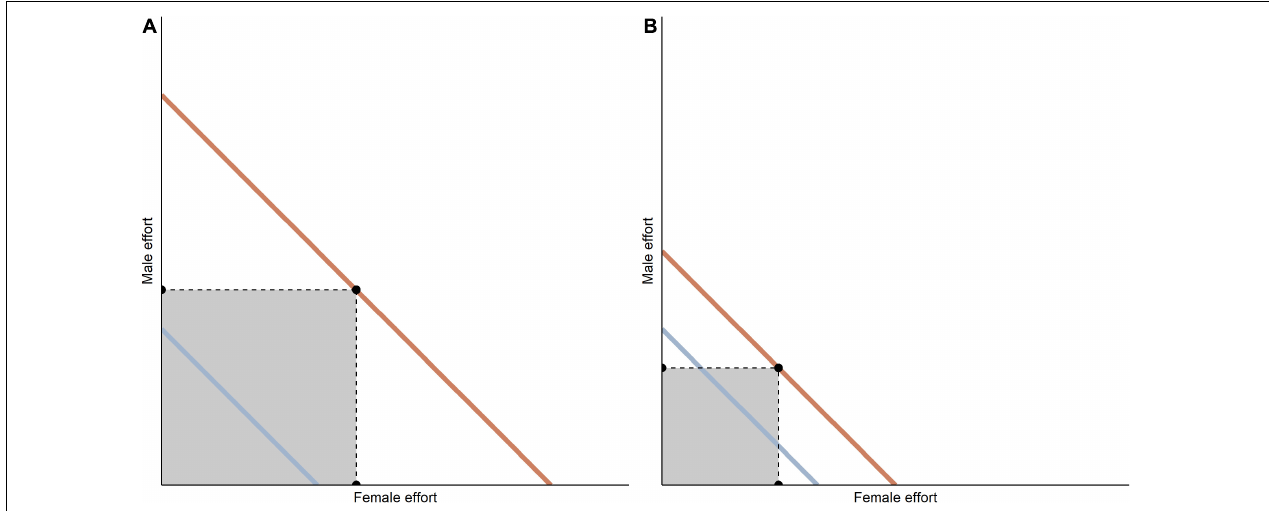
FIGURE 1 | Total amount of parental care required by the offspring as a function of male and female parental effort. Multiple lines are possible within the ranges defined by the least (red solid) and the most favorable (blue solid) environmental conditions experienced by a species in an evolutionary scale. The two points on the axis for each parent and the grey area denote optimal range of parental capacity. (A) Species of wide parental capacity, adapted to highly variable environments. (B) Species of narrow parental capacity, adapted to harsh and/or predictable